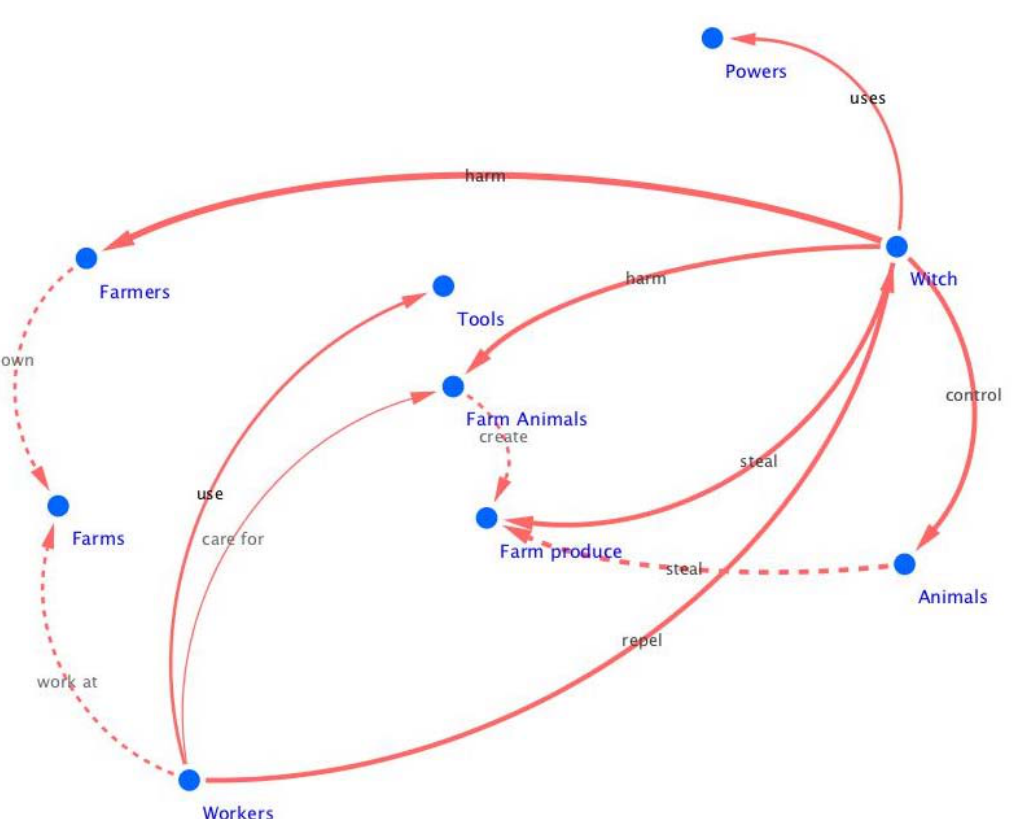
Figure 7. Activation through legend performance of a small part of the much larger witchcraft— cunning folk domain in Danish rural tradition. Inferred relations are represented by dotted lines. There are no differential weights on the edges since this graph represents a single telling/activation of the narrative framework.